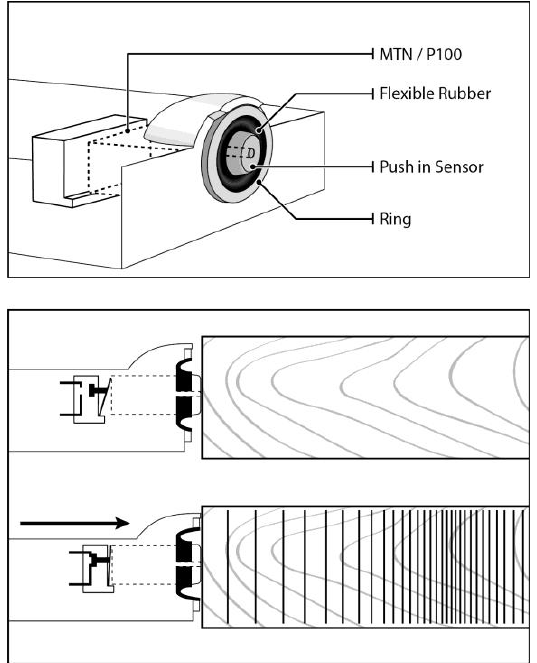
Figure 1. A graphical representation showing how the Monitran P100 accelerometer (MTN/P100) is attached to the push-in sensor of HM200. When the tool is pressed against a piece of wood, the leaf spring located at the back of the accelerometer activates a microswitch to provide electrical power and initiate the